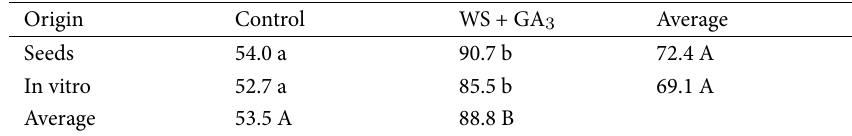
Table 6 Germination ability of Primula farinosa seeds (%) collected in ex situ conditions from seed-derived and micropropagated plants after application of gibberellin and wet stratification in 2015.